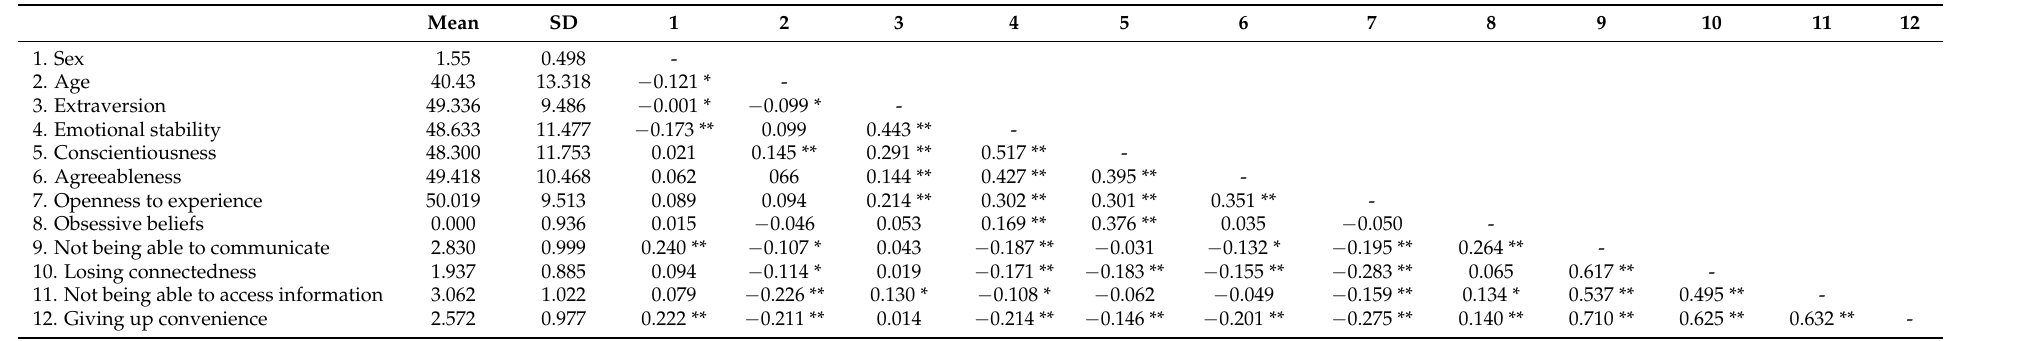
Table 1. Descriptive analysis (mean and standard deviation) and